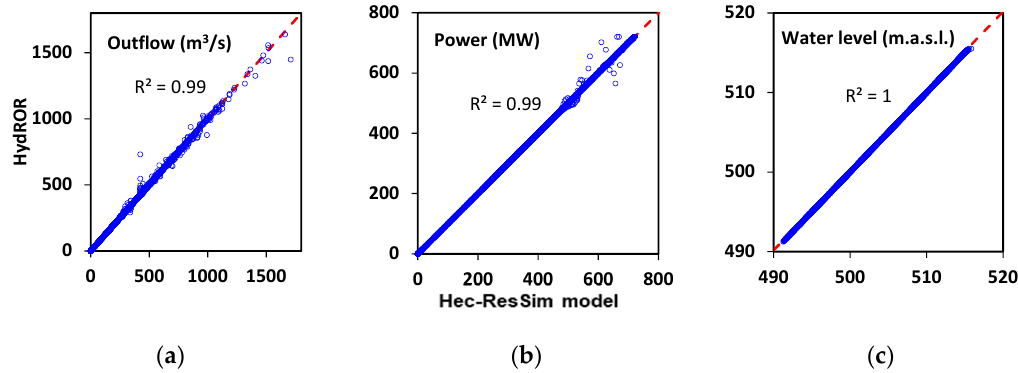
Figure 4. Scatter plots of ( a ) outflow, ( b ) power generation and ( c ) water level for HydROR (vertical axes) and HEC-ResSim (horizontal axes).